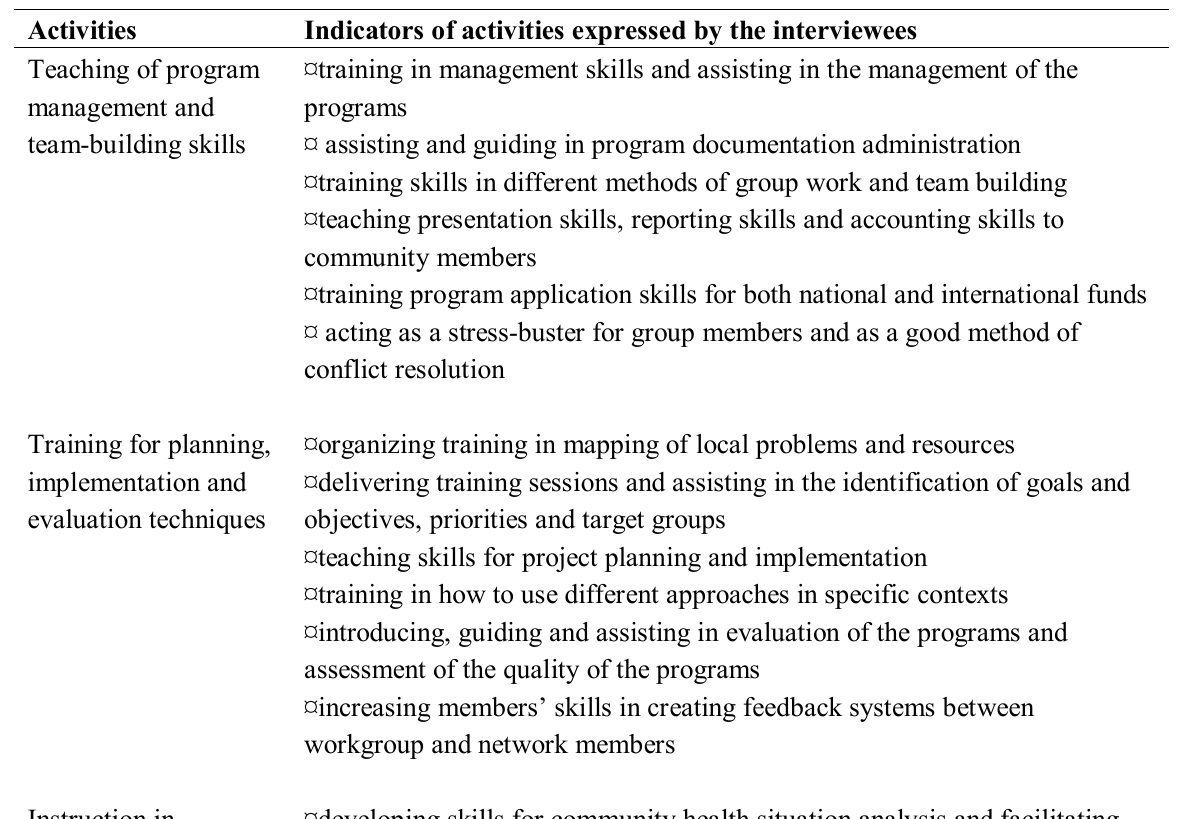
Table 6. Activities and indicators of activities expressed as empowering by the interviewees within the domain of Management